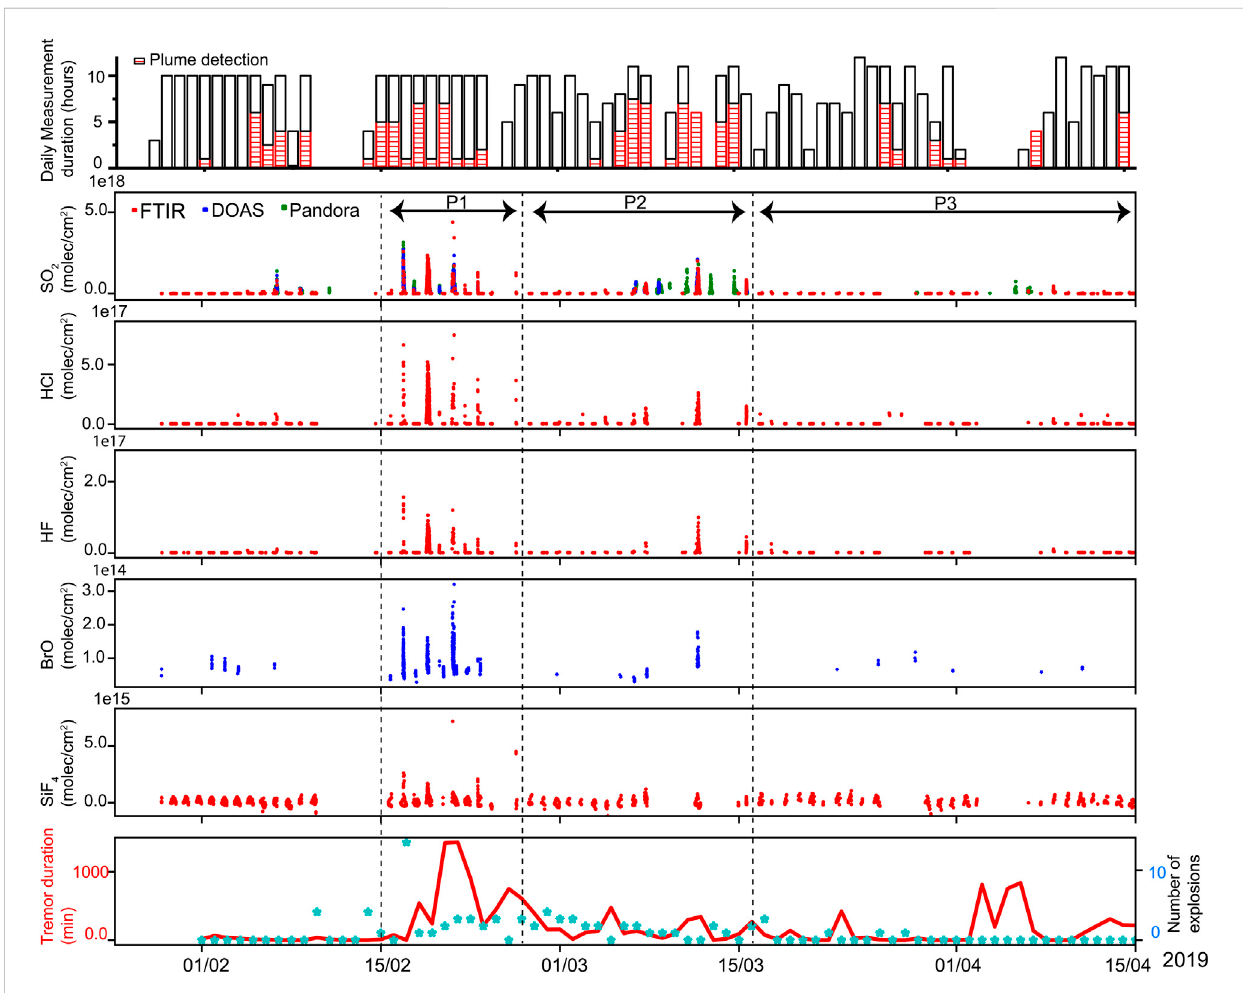
Table 3. SO 2 vertical columns obtained from the DOAS measurements using the two different strategies described